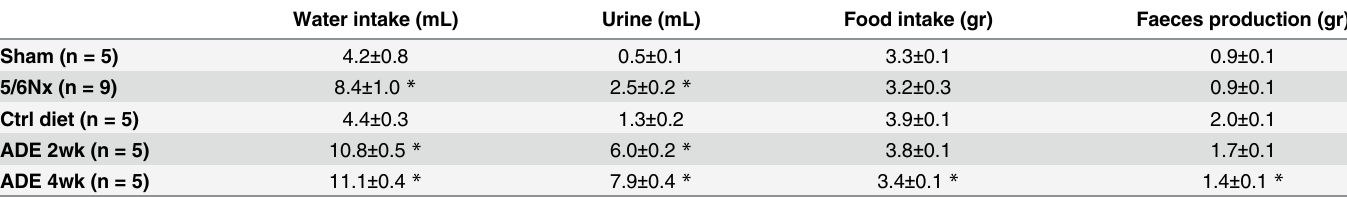
Table 1. The effects of induced CKD on general physiological parameters.